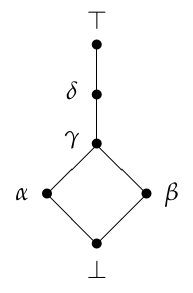
Figure 3. Lattice ( L , (cid:22) )